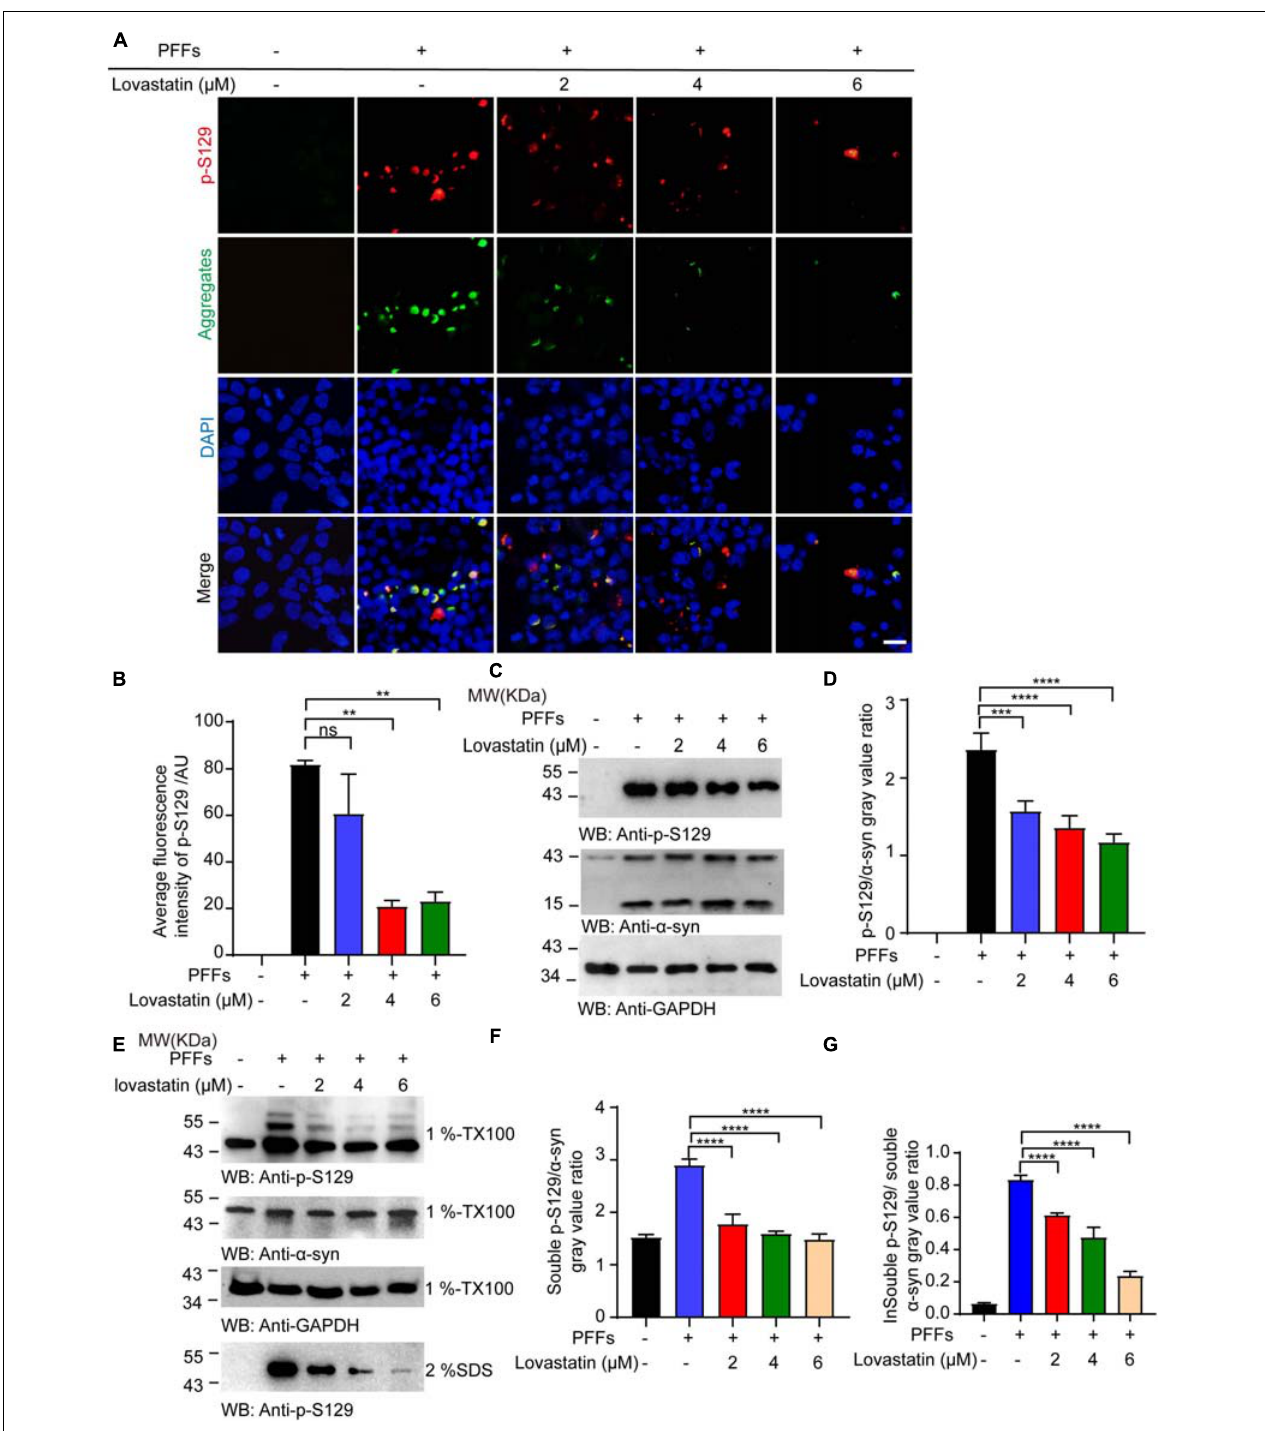
FIGURE 2 | Lovastatin attenuates α -syn phosphorylation in GFP- α -syn-HEK293 cells. (A) Immunofluorescence showing that p-S129 co-localized with α -syn aggregates. Intracellular p-S129 α -syn (red) was decreased in the lovastatin group. (B) Quantitative analysis of p-S129 α -syn fluorescence. (C) Western blot analysis of the p-S129 level. (D) Quantification of the p-S129 level in Western blot. Results are normalized to total α -syn. (E) Western blot analysis of soluble and insoluble p-S129 α -syn. (F) Quantification of soluble p-S129 α -syn. Results are normalized to total α -syn. (G) Quantification of insoluble p-S129 α -syn. Results are normalized to total α -syn. All data are means ± SEM, ** P < 0.01, *** P < 0.001, and **** P < 0.0001, ns: not statistically significant, one-way ANOVA with Tukey’s multiple comparisons test. Bar = 20 µ m. All experiments were performed in triplicate for at least three independent times.